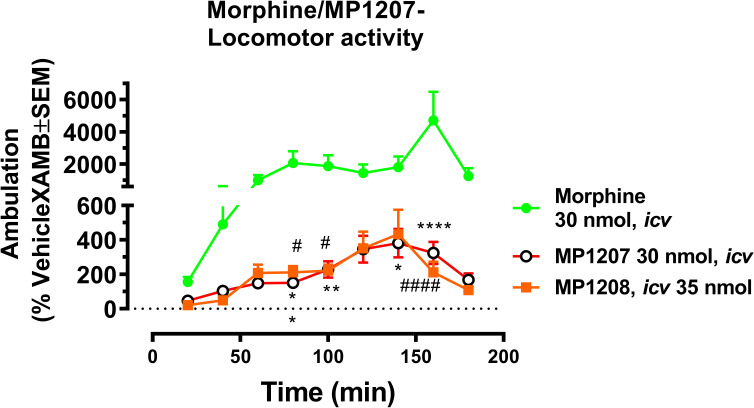
MP1207 and 1208 show significantly less hyperlocomotion compared to morphine.Mice were administered icv either morphine (30 nmol; n = 18), MP1207 (30 nmol; n = 26) or MP1208 (35 nmol; n = 10) and the ambulation of each group of mice monitored using the CLAMS/Oxymax system. Morphine (30 nmol, icv) significantly increased forward ambulation in comparsion to MP1207 at 80 min (**p=0.002), 100 min (**p=0.01), 140 min (*p=0.03), and 160 min (****p<0.0001) as determined by two-way ANOVA followed by Dunnett’s multiple-comparison test. Similarly, significant morphine-induced increases in ambulation as compared to the response of MP1208 were observed at 80 min (#p=0.0249), 100 min (#p=0.0497), and 160 min (####p<0.0001) as determined by two-way ANOVA followed by Dunnett’s multiple-comparison test.